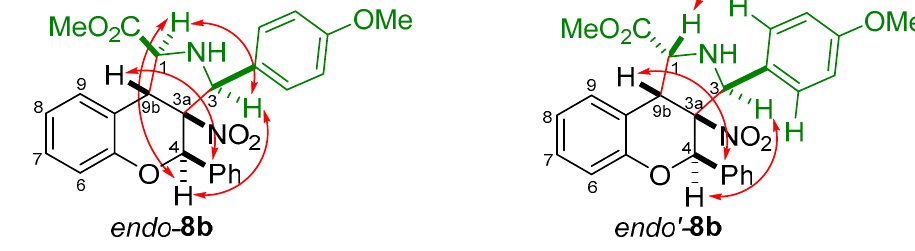
Figure 3. The main correlations in the 2D 1 H − 1 H NOESY spectra of endo - 8b and endo’ - 8b . The relative configuration of endo chromeno[3,4- c ]pyrrolidines 8 and 9 was unambigu- ously confirmed by single crystal X-ray diffraction analysis of compounds endo - 8b and endo - 9a (Figures 4 and 5). In both molecules, the H-1, H-3, and H-4 atoms are located on one side of the condensed tricyclic system, with the 4-Ph or 4-CF 3 -group occupying the axial position, while the nitro group is in the equatorial positions. The pyran and pyrrolidine rings have half-chair and twist conformations, respectively.